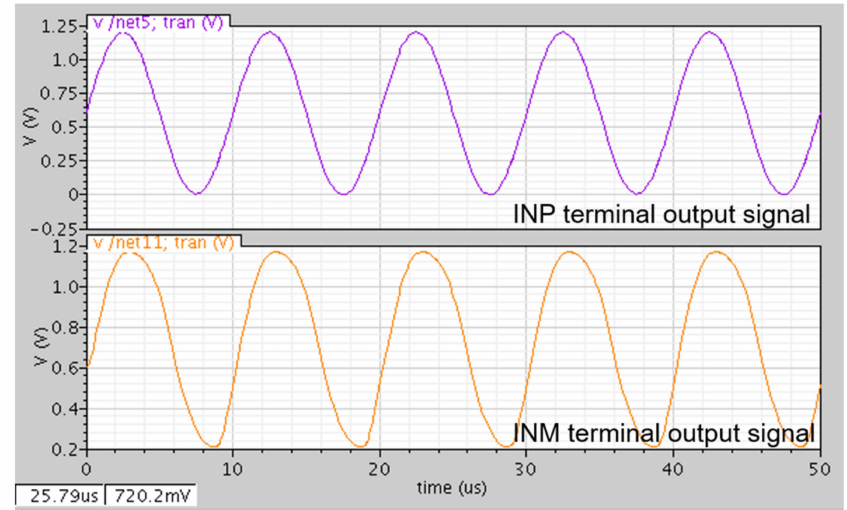
Figure 8. Comparison of delay difference between INP and INM.